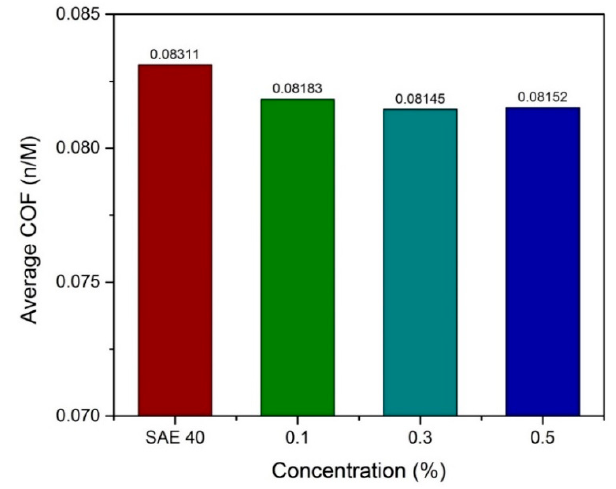
Figure 15. Average COF results at low-speed high load.